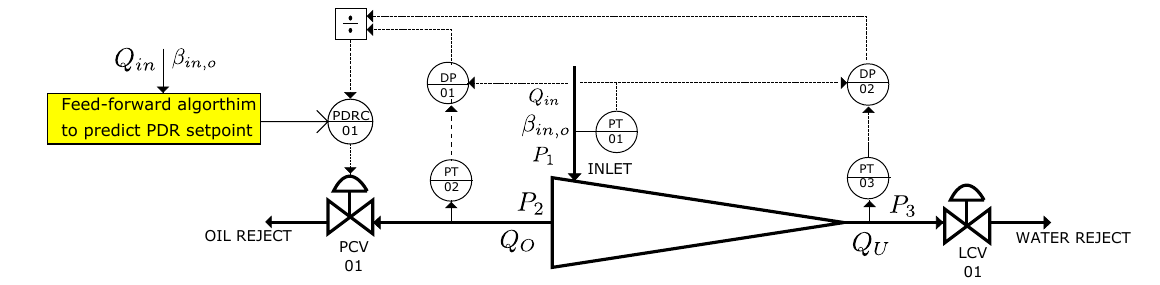
Figure 6: A diagrammatic representation of the feed-forward approach adjusting the PDR setpoint